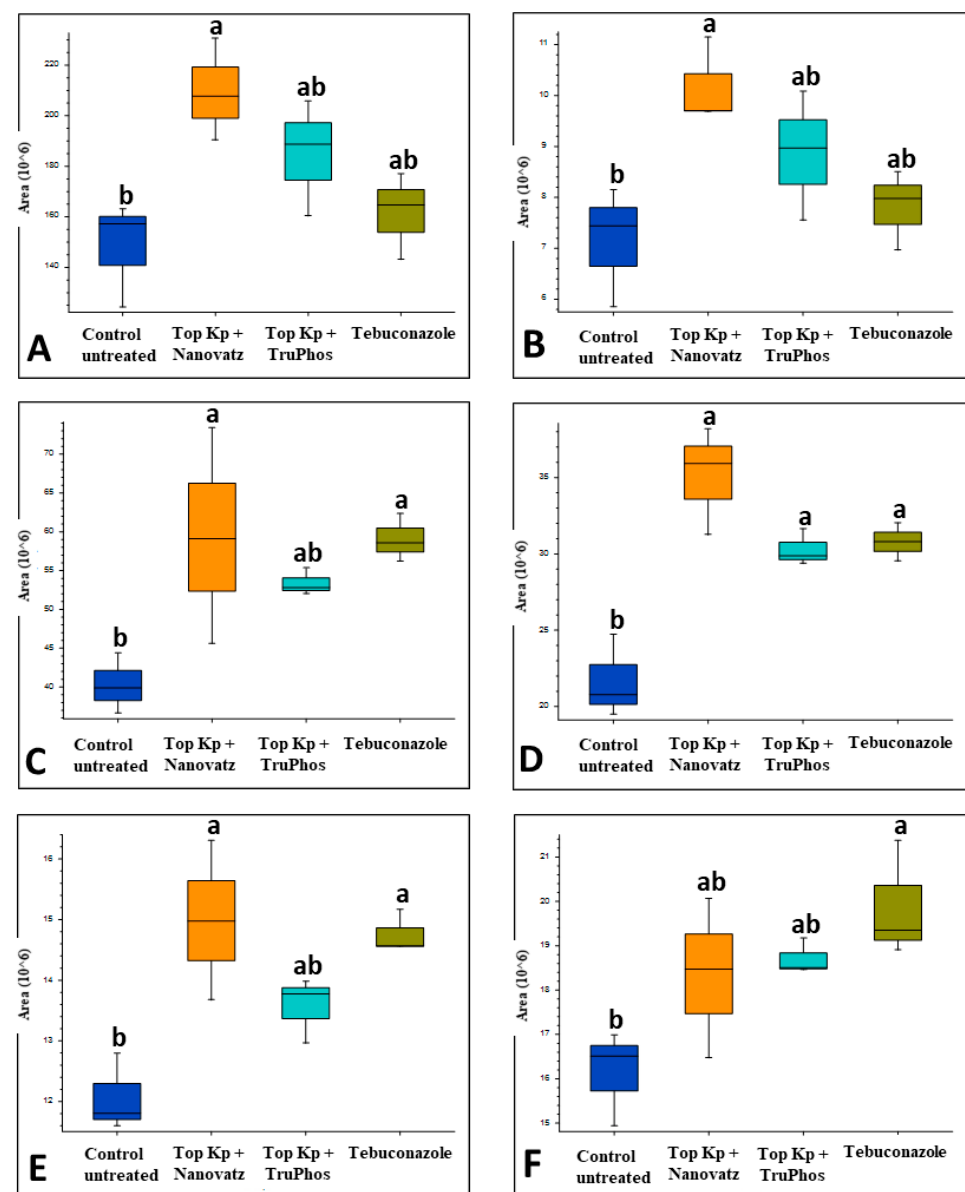
Figure 8. Relative amounts (peak area) of metabolites that were up-produced in grape skins of cv. Carignan vines treated with six foliar spays (starting at April 6 until June 8) of the fungicide Folicur (tebuconazole) 0.02%, or the fertilizers Top KP+ 1% plus Nanovatz 0.1%, Top KP+ 1% plus TruPhos 0.25%, compared to control untreated vines. Analysis was conducted using LC–MS/MS. ( A ) Trans-3-Indoleacrylic acid, ( B ) Indole, ( C ) Phytosphingosine, ( D ) 6-hydroxysphing-4E-enine, ( E ) Limocitrin, ( F ) (±)-(2E)-Abscisic acid. Different letters represent significant differences ( p < 0.05, Tukey-Kramer HSD test).